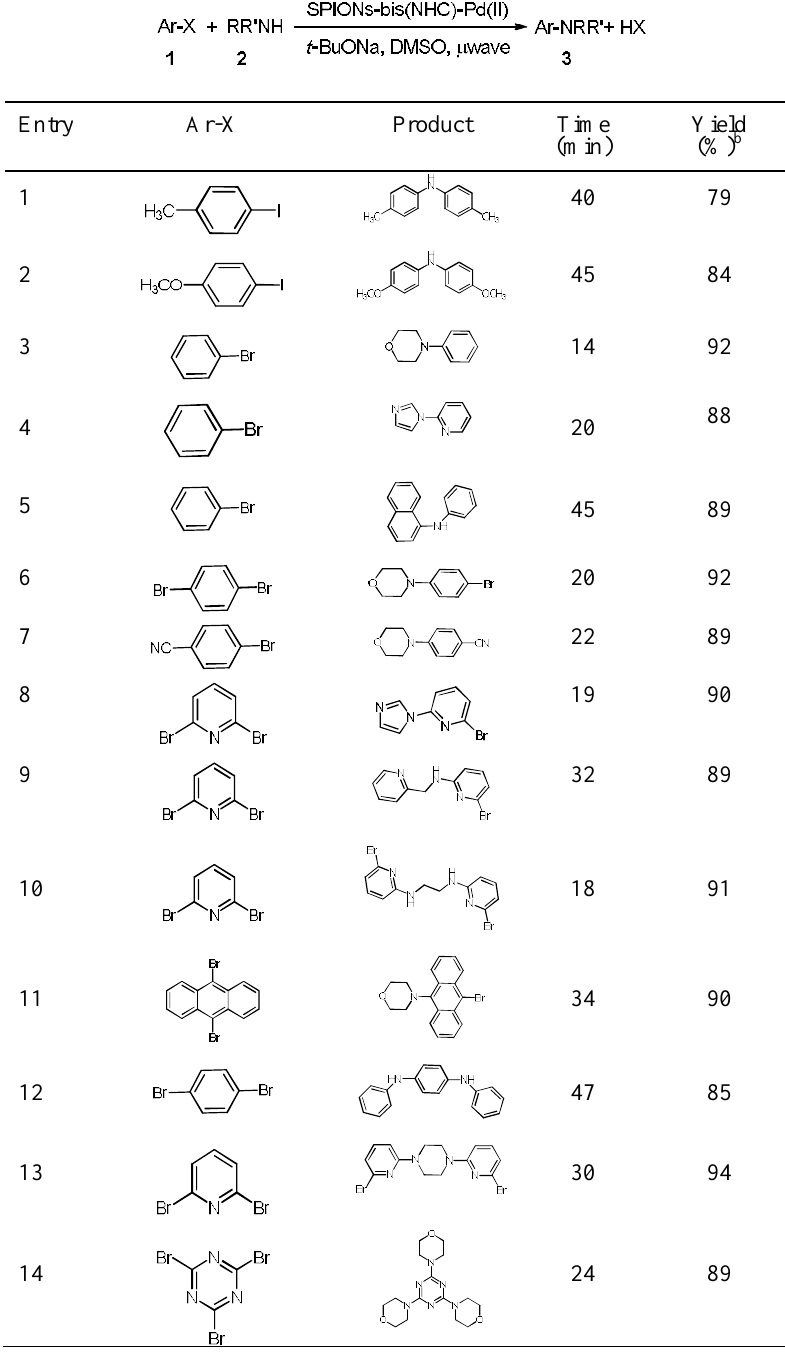
Table 3. Buchwld-Hartwig Reaction of 1 and 2 Under MicroWave Irradiation a